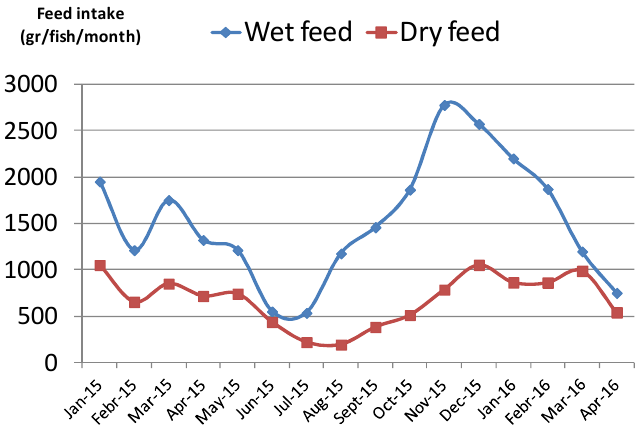
Figure 2 . Mean feed intake (gr/fish/mounth) of the indoor Instituto Español de Oceanografía broodstocks during 2015.